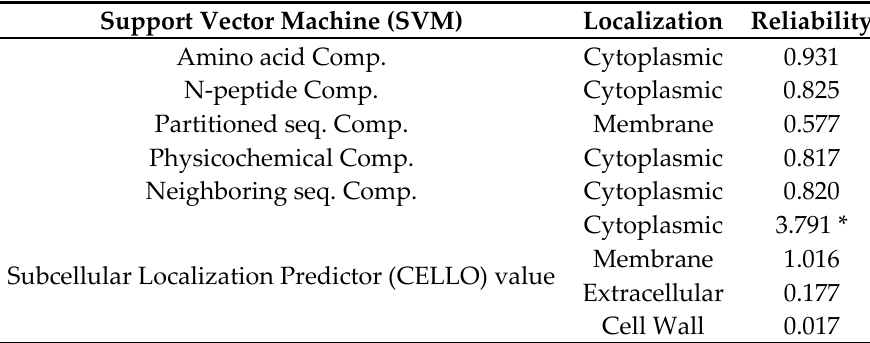
Table 4. Subcellular localization analysis